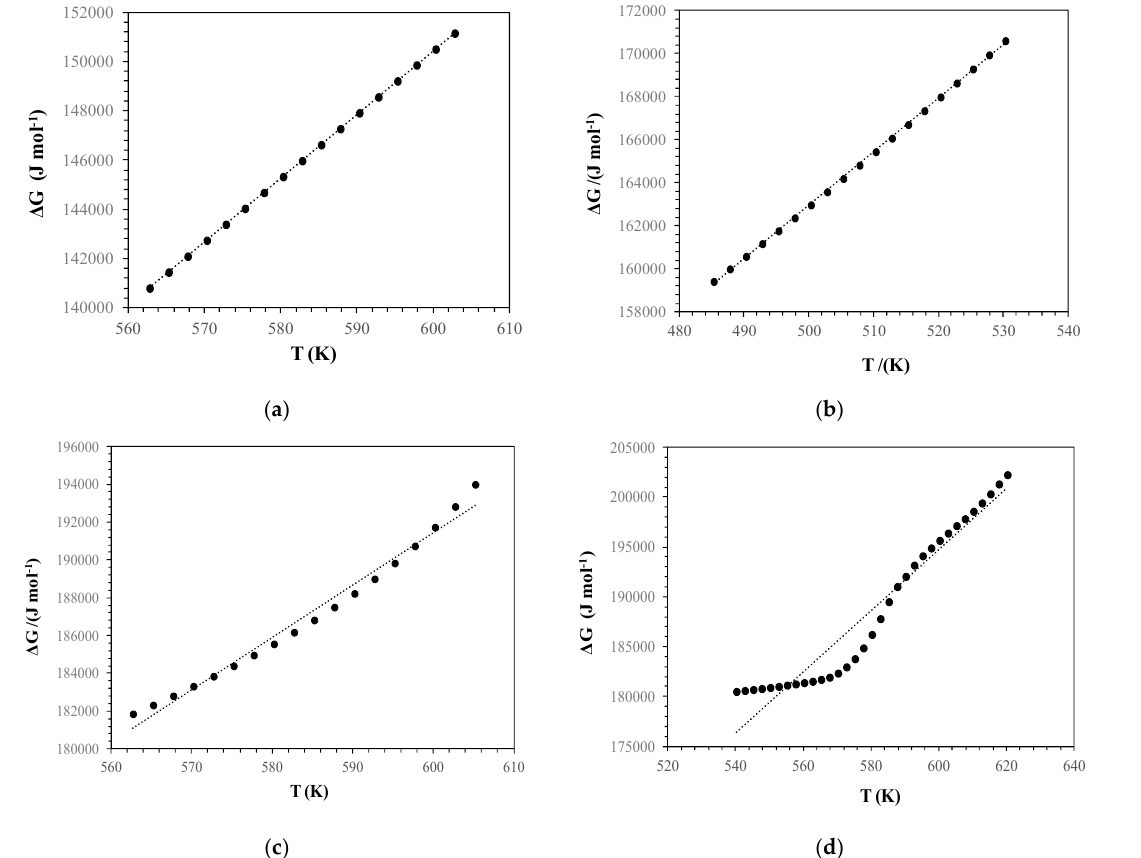
Figure 5. Free enthalpy versus temperature plot of ( a ) rice starch; ( b ) potato starch; ( c ) wheat starch; and ( d ) corn starch.